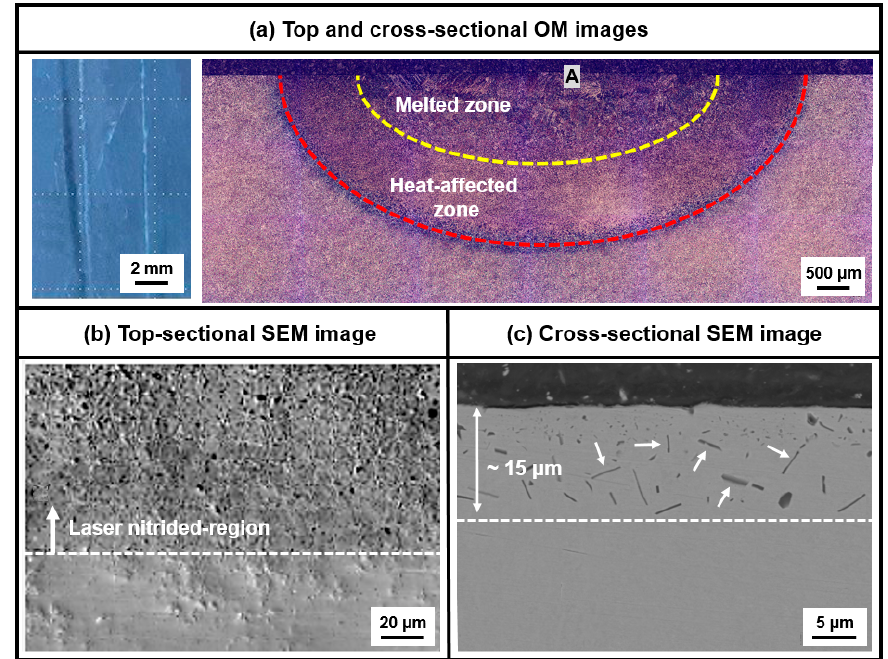
Figure 7. Microstructure of the LN P21; ( a ) top- and cross-sectional OM images and ( b ) top-sectional and ( c ) cross-sectional SEM images at the location of top surface labeled as “A.”